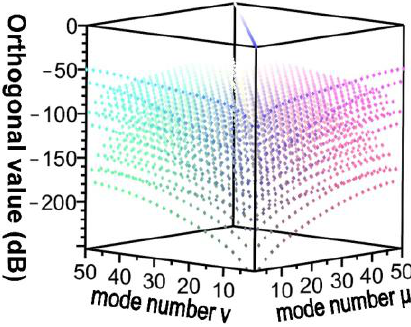
Figure 24. Plot between the propagation length and power loss for the total coupling from HE to a counterpropagating cladding mode (ν = 21) with N = 120,000, Λ = 0.53537 μm, 11 L = L + L + L = 64,444.4 μm. 1 2 3